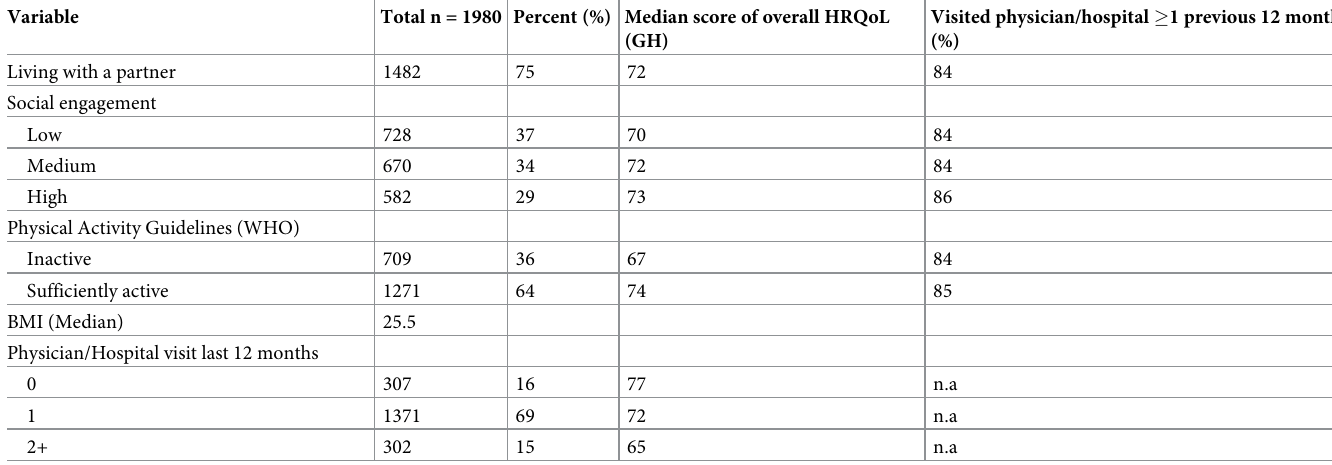
PLOS ONE | https://doi.org/10.1371/journal.pone.0251251 May 6,